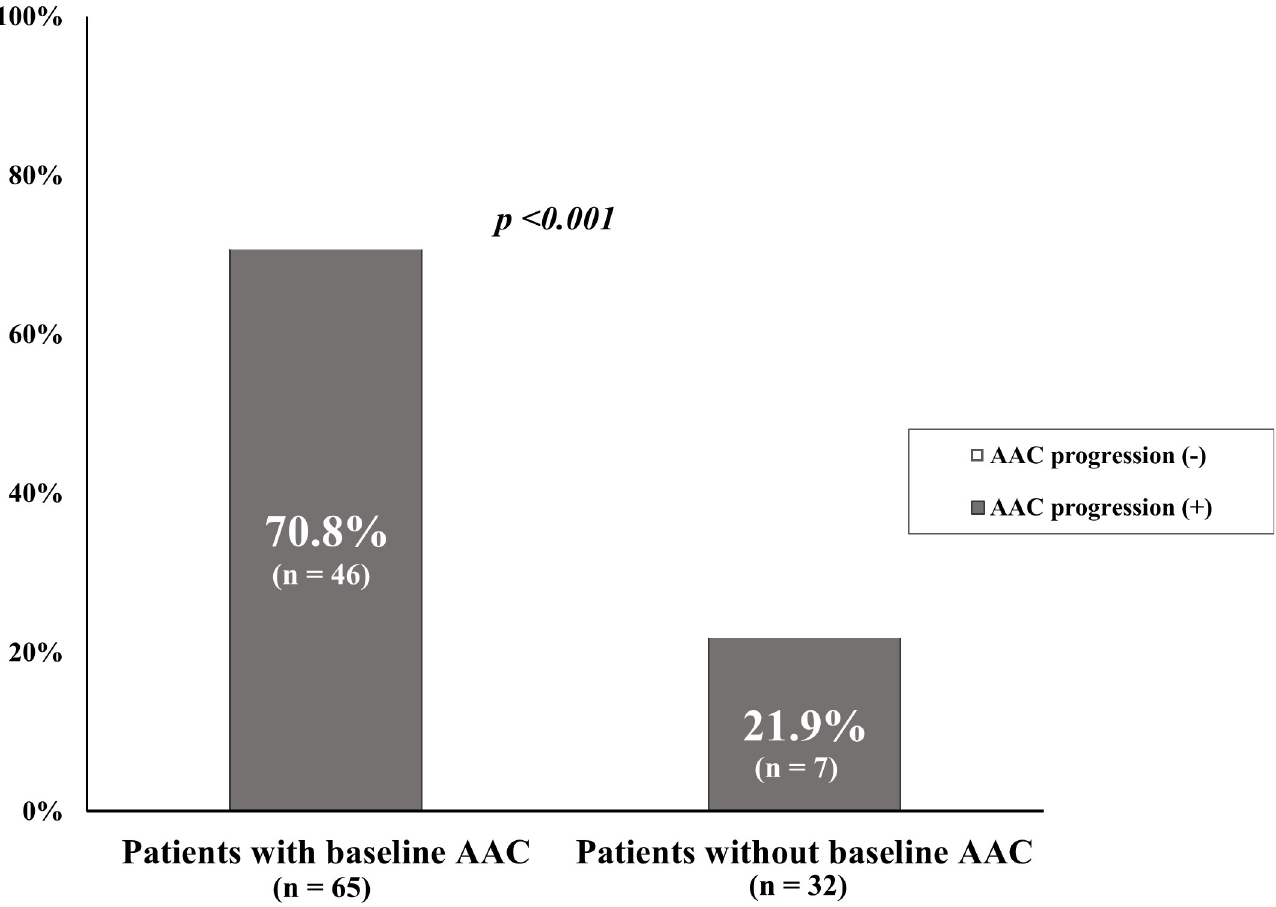
Fig 1. Portion of patients with and without AAC progression according to presence or absence of baseline AAC. AAC, abdominal aortic calcification.